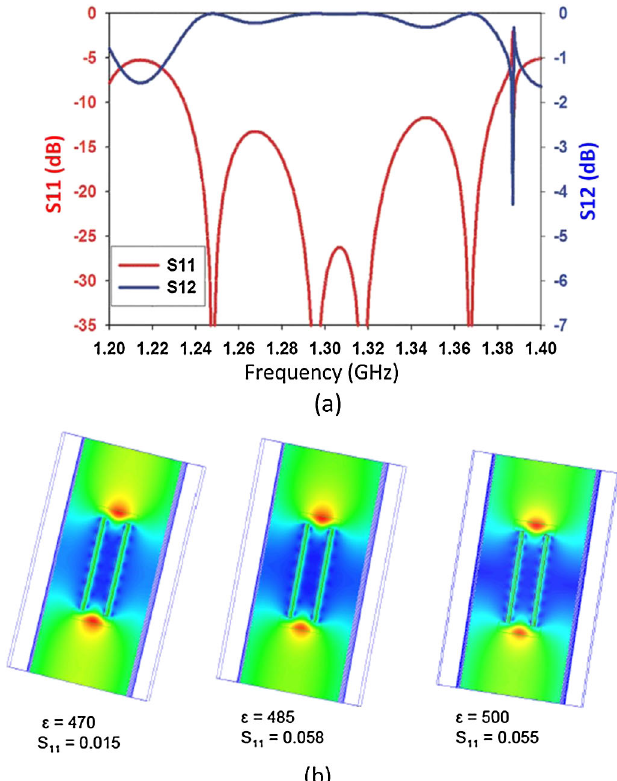
FIG. 6. (a) Frequency response for sandwich geometry with " (cid:1) 470 ; it is nearly the same for 470 < " < 500 . (b) Field pattern demonstrates that the geometry is well matched for different values of the dielectric constant of the